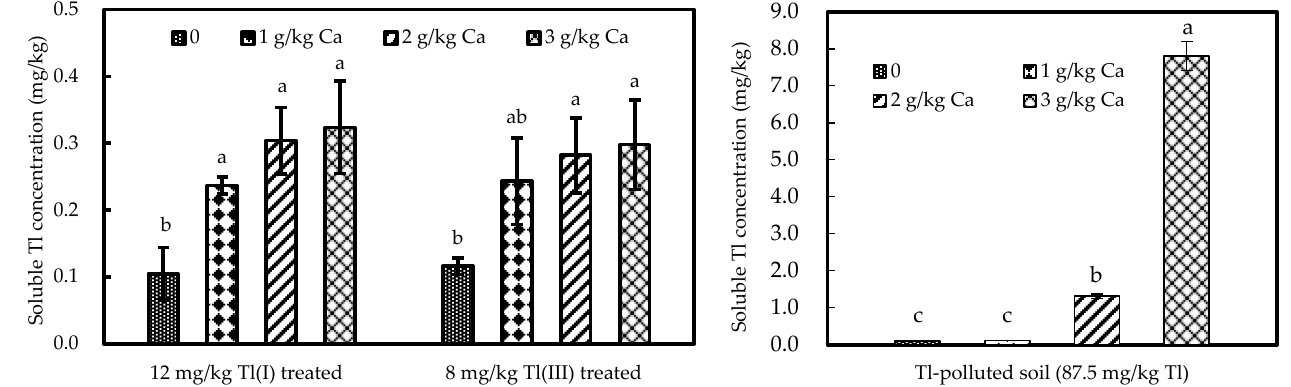
Figure 5. The concentration of Tl chemically solubilized by Ca. Bars denote standard deviation from means of three replicates. Significant differences among different Ca solutions are indicated by lowercase ( p < 0.05).